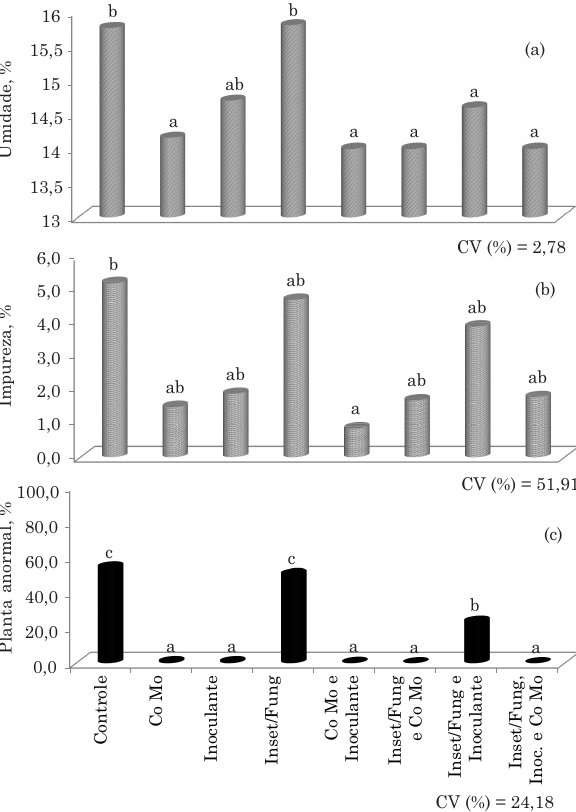
Figura 4. Umidade dos grãos na colheita (a), impurezas na colheita (b) e percentual de plantas anormais (c) em função de diferentes tratamentos de sementes. Safra 2010/11. Médias seguidas de mesma letra não diferem pelo teste de Tukey